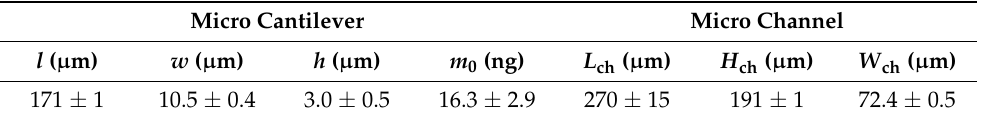
Table 2. Parameters of the piezoresistive micro cantilever (PMC)- µ FC ( l , w , h : length, width, height of the PMC; L ch , H ch and W ch : length, height and width of the µ FC). Micro